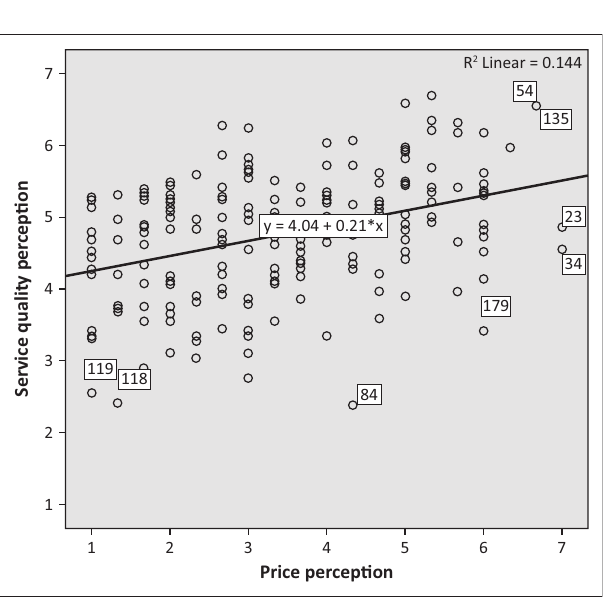
* , The mean difference is significant at the 0.05 level.